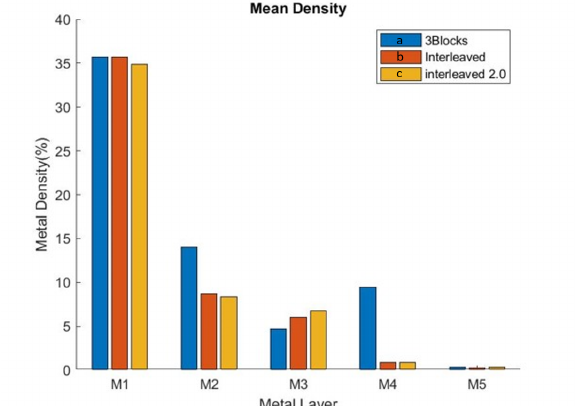
Figure 9. Average design metal density for different metal layers: ( a ) 3Block ( b ) Interleaved ( c ) Improved